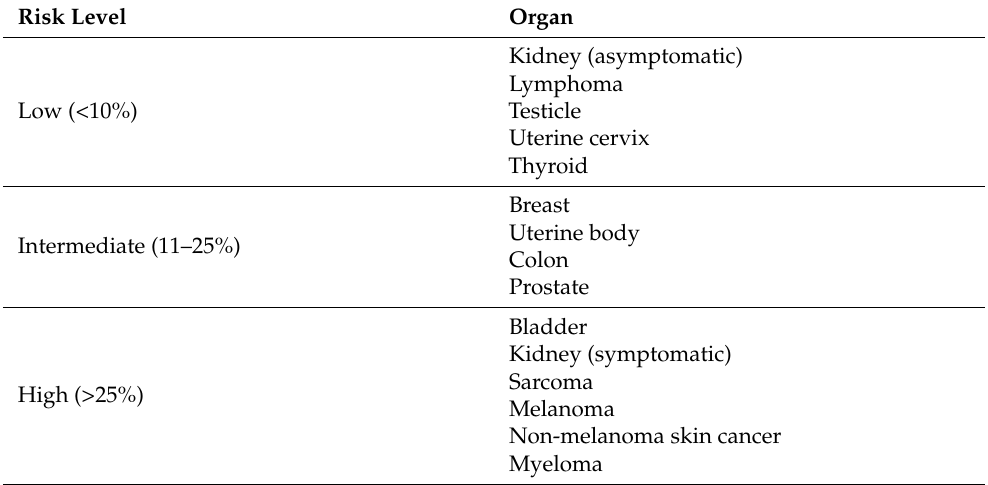
Table 1. Risk of recurrence of pre-existing cancer under post-transplant immunosuppressive therapy (adapted from Penn et al.